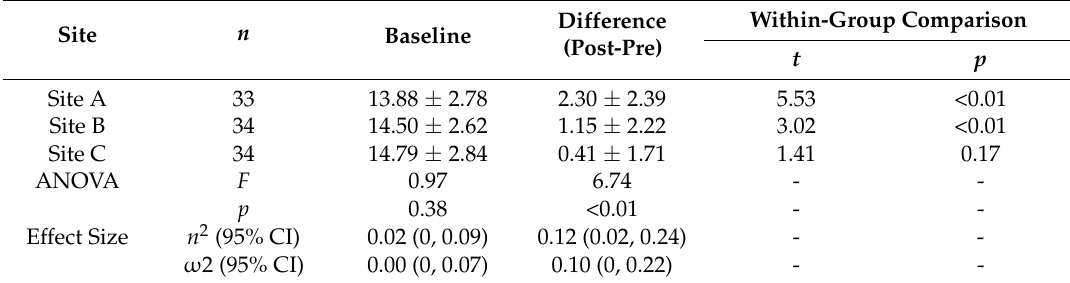
Table 7. Pre- and post-visit comparison of levels of joy across the three sites (n = 101).